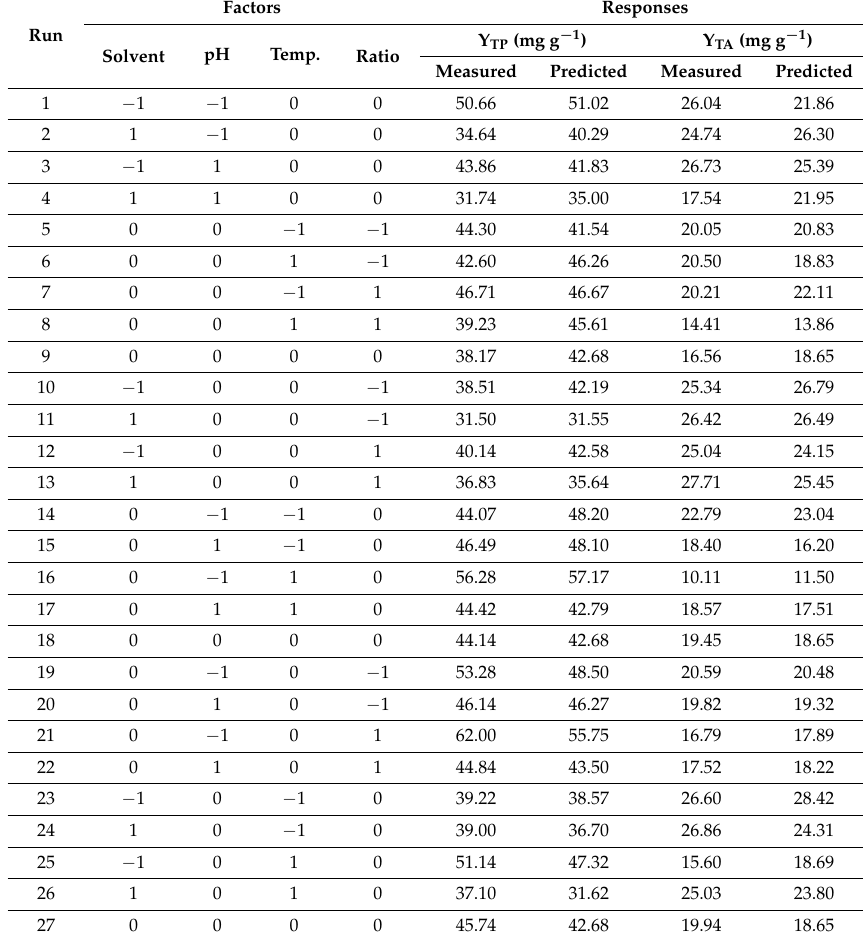
Table 4. Box–Behnken design matrix of four variables, and measured and predicted responses. Run